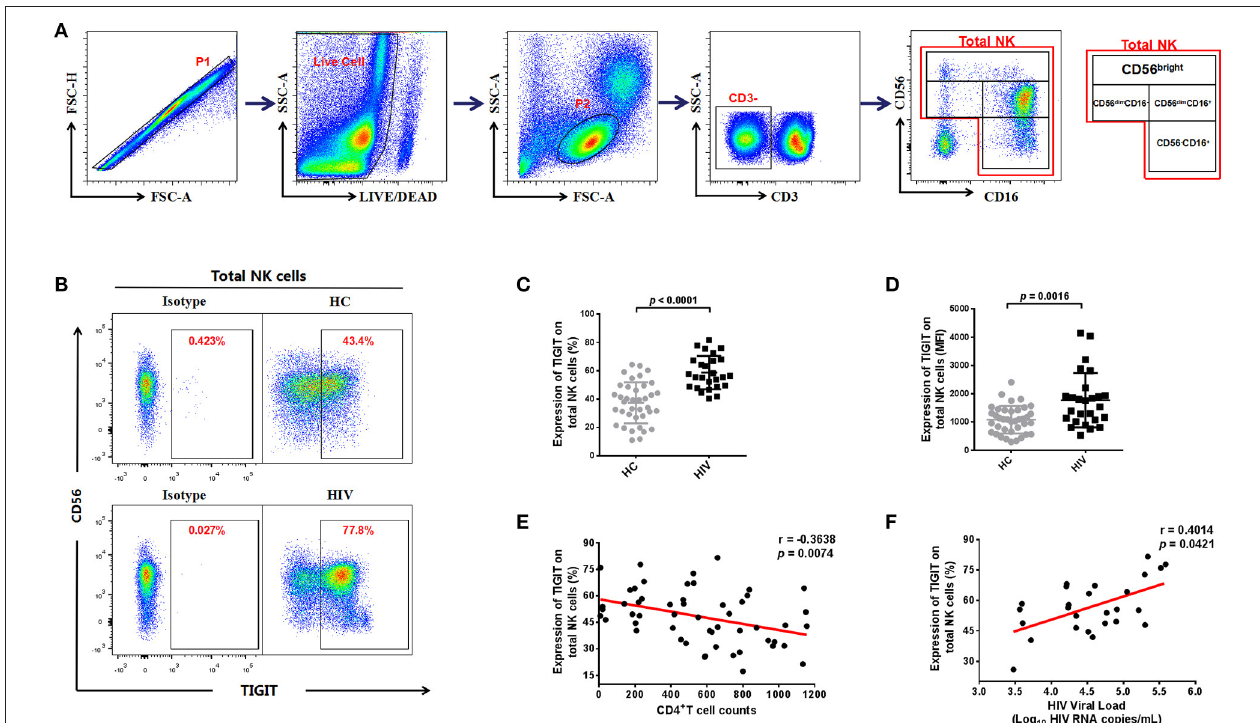
FIGURE 1 | The expression of TIGIT on NK cells is higher in HIV-infected individuals and correlated with HIV disease progression. (A) Gating strategy used to identify total natural killer (NK) cells and NK cell subsets. Single cells were gated using the forward scatter area (FSA) and forward scatter height (FSH), then live cells were gated by Live/Dead (BV510) staining. Lymphocytes were gated according to forward scatter/side scatter properties (FSC/SSC). Total NK cells were identified from CD3-negative lymphocytes by their expression of CD16 and/or CD56. The four NK cell subsets identified were CD3 − CD56 bright CD16 − / + , CD3 − CD56 dim CD16 + , CD3 − CD56 dim CD16 − , and CD3 − CD56 − CD16 + . All the plots were based on an HIV + individual. (B) A representative flow cytometry plot showing the different percentages of TIGIT on NK cells in the HC and HIV groups. The expression of TIGIT was gated according to an isotype control. (C) Comparison of the percentages of TIGIT on NK cells from the HIV ( n = 26) and HC ( n = 38) groups. (D) Comparison of the MFI of TIGIT on NK cells from the HIV ( n = 26) and HC ( n = 38) groups. (E) Analysis of the correlation between TIGIT expression on NK cells and absolute CD4 + T cell counts (cells/mm 3 ) at the same sampling time ( n = 53). (F) Analysis of the correlation between the proportion of TIGIT on NK cells and plasma levels of HIV RNA (Log– 10 HIV RNA copies/mL) at the same sampling time ( n = 26). A Mann-Whitney U test was used for comparisons between two groups. Error bars indicate the median and interquartile range. Spearman’s rank analysis was employed for evaluation of correlation. p < 0.05 was considered